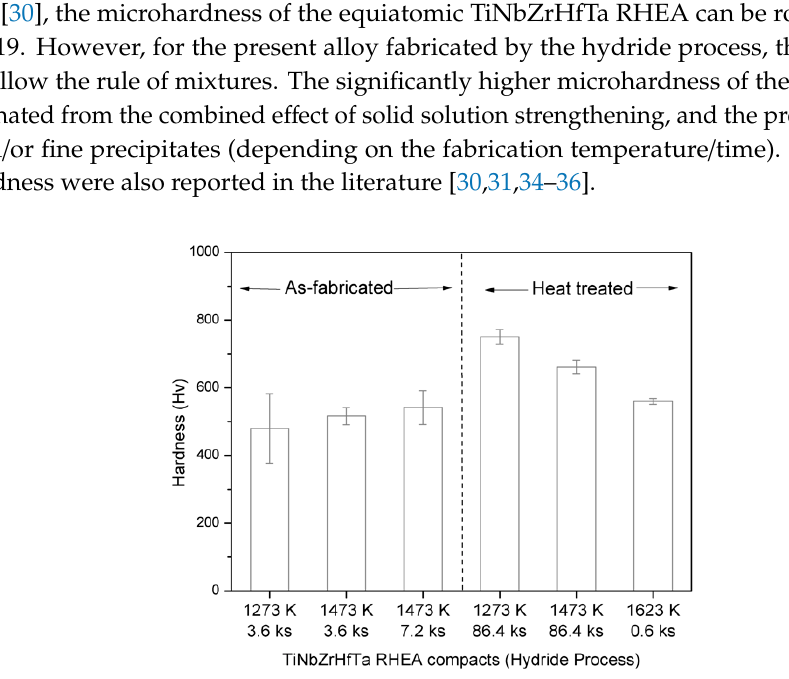
Figure 10. The Vickers microhardness of the TiNbZrHfTa compact prepared with different sintering and heat treatment conditions.